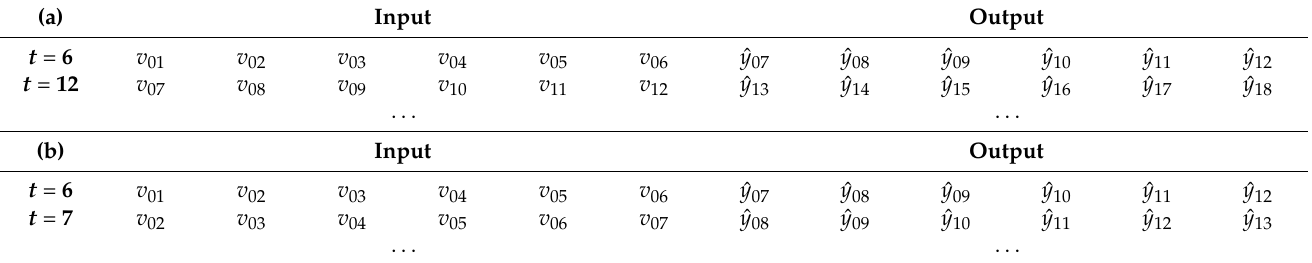
Table 1. Example of the input–output patterns (time step equal to 10 min) for models with an input update frequency of 60 (a) and 10 min (b). In the autoregressive approach, the input vector v only contains previous water stages y ; in the multivariable approach, the rainfall records are also